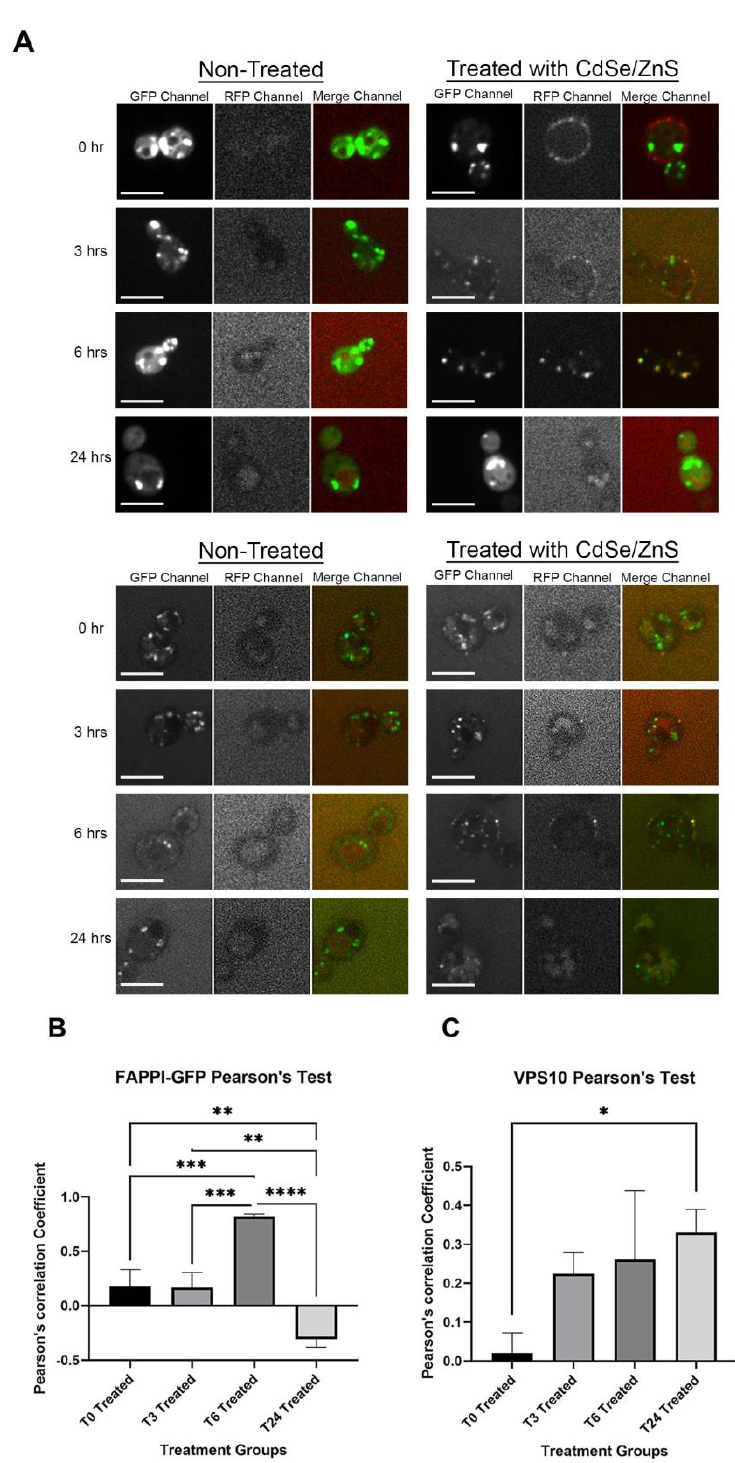
Figure 3. QDs’ intracellular trafficking. Cells expressing FAPPI-GFP or Vps10-GFP were cultured in SD-HIS for 0 h, 3 h, 6 h, and 24 h with or without QDs (4 μ g/mL). The microscopic images were obtained from different channels (in order: GFP, RFP, and merge) for control on the left and QD-treated on the right. The size bar is equivalent to 5 μ m. ( A ) Confocal microscopy images of the late Golgi/trans-Golgi network (top) and confocal image of the late endosome (bottom). Images ( B ) and ( C ) showed the graphs of Pearson’s correlation coefficient of QDs with different reference markers. ( B ) Graph for QDs and FAPPI-GFP colocalization and ( C ) graph for QDs and the Vps10-GFP colocalization. * p < 0.05, ** p < 0.01, *** p < 0.001, **** p < 0.0001.